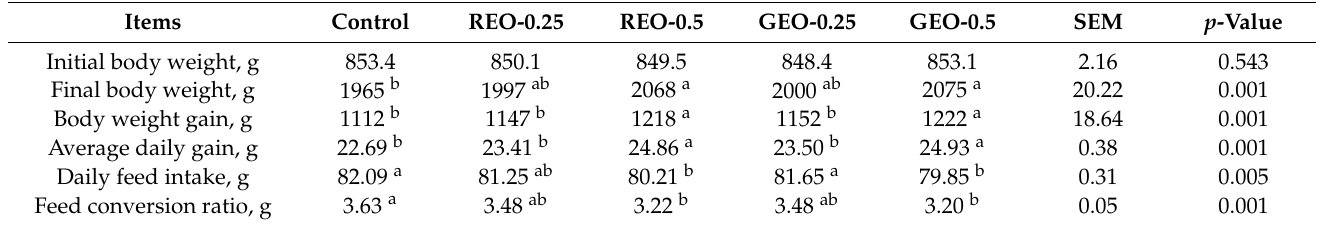
Table 3. Effect of the dietary supplementation of rosemary and ginger essential oils on the growth performance of the growing NZW rabbits from 7th to 13th week of age ( n = 24, 6 replicates in each group with 4 rabbits in each replicate).